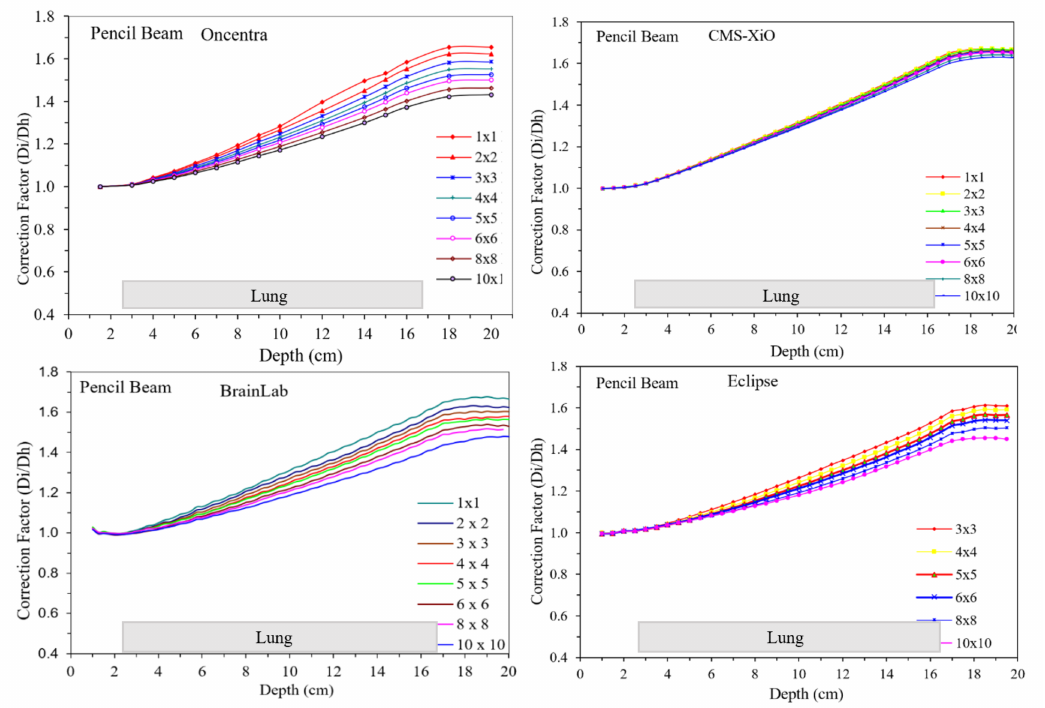
Figure 3. Calculated doses with different field sizes in a lung phantom using pencil beam-type algorithms. Note the location of the lung material and the shape of the various curves. Though trends appear similar, the magnitudes are different.